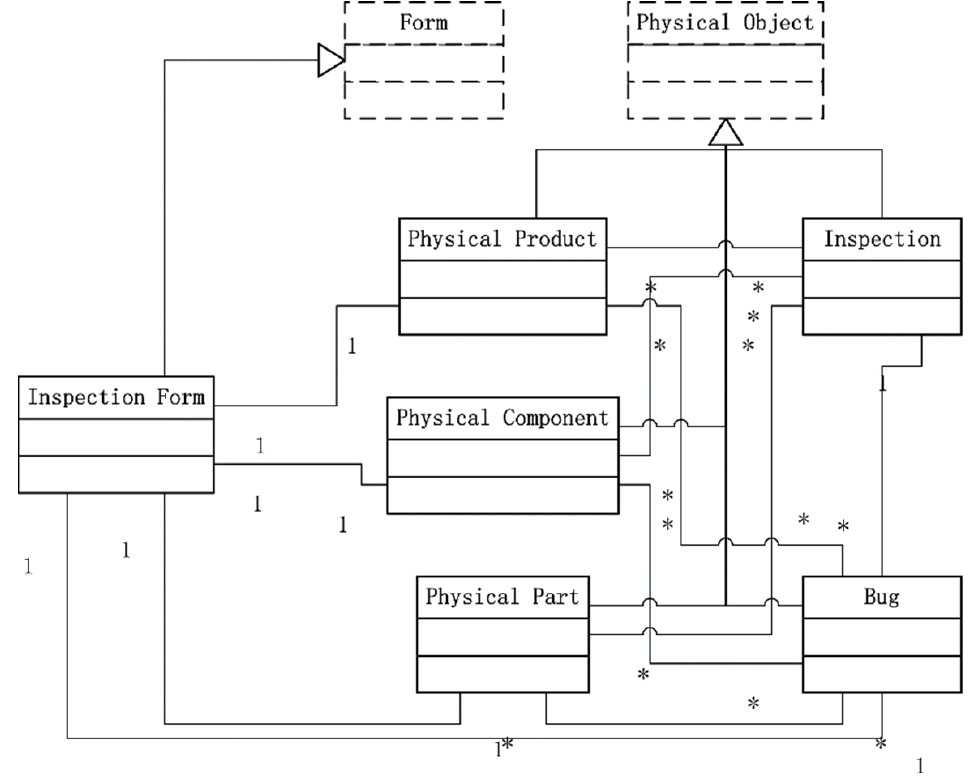
Figure 8. Inspection Private Data Model (1, * represent the one and multi-object). Service contains the use, maintenance, repair, and overhaul. The data contain the working condition, failure, maintenance, repair, overhaul, and complaint. Based on PCDM, SPrDM is built, as shown in Figure 9. The Physical Product is owned by a Customer, who has Gripe, and has many uase data, which involved Working Condition and brings Failure. It has MRO, including Maintain, Repair and Overhaul. MRO addresses the Failure of Physical Product, Physical Component and Physical Part. Physical Product, Physical Component and Physical Part have Service Form managing their attributes in the Service